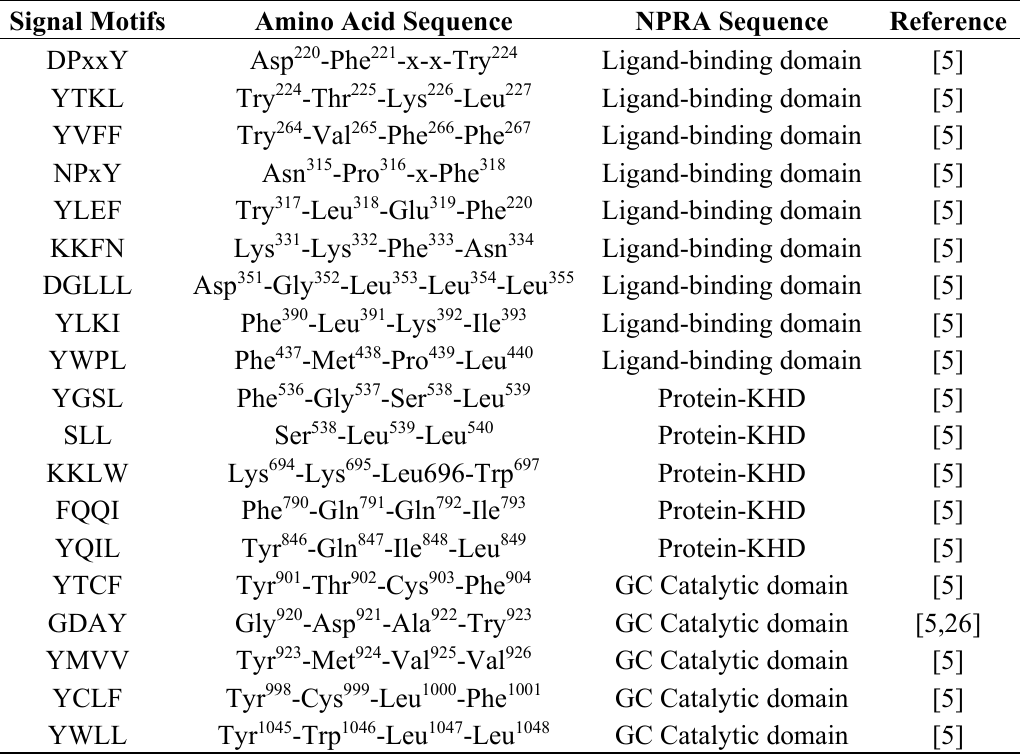
Table 2. A list of putative signal sequence motifs located in the extracellular ligand-binding region, protein kinase-like homology domain, and guanylyl cyclase catalytic domain of natriuretic peptide receptor-A